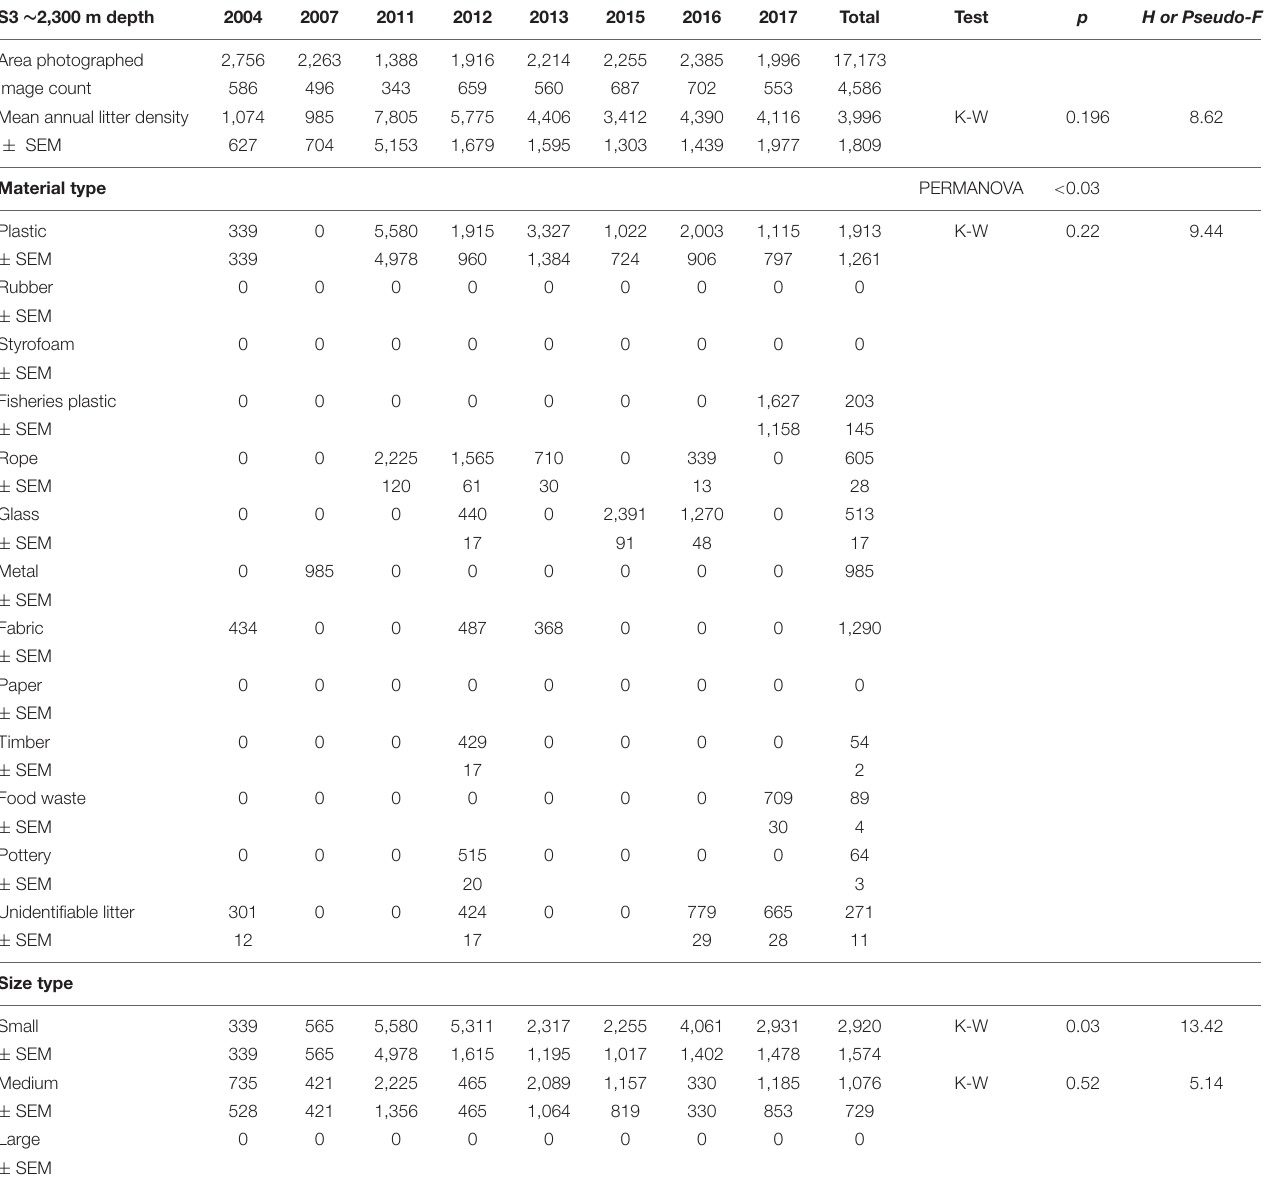
TABLE 5 | Summary of the area covered (m 2 ), mean litter densities (items km − 2 ), material and size composition at HAUSGARTEN station S3. S3 ∼ 2,300 m